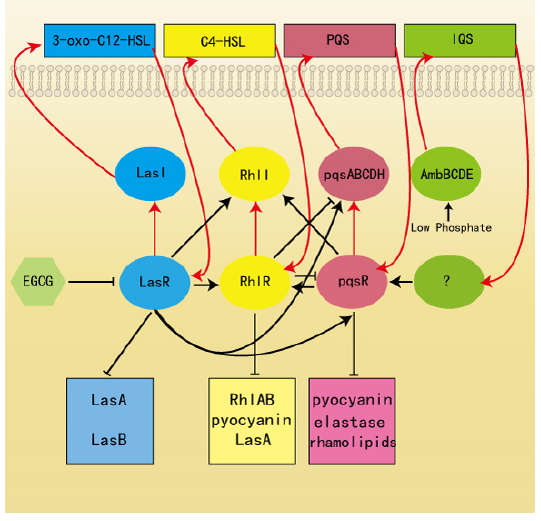
Figure 14. Quorum sensing circuits in P. aeruginosa and the action mechanism of EGCG.